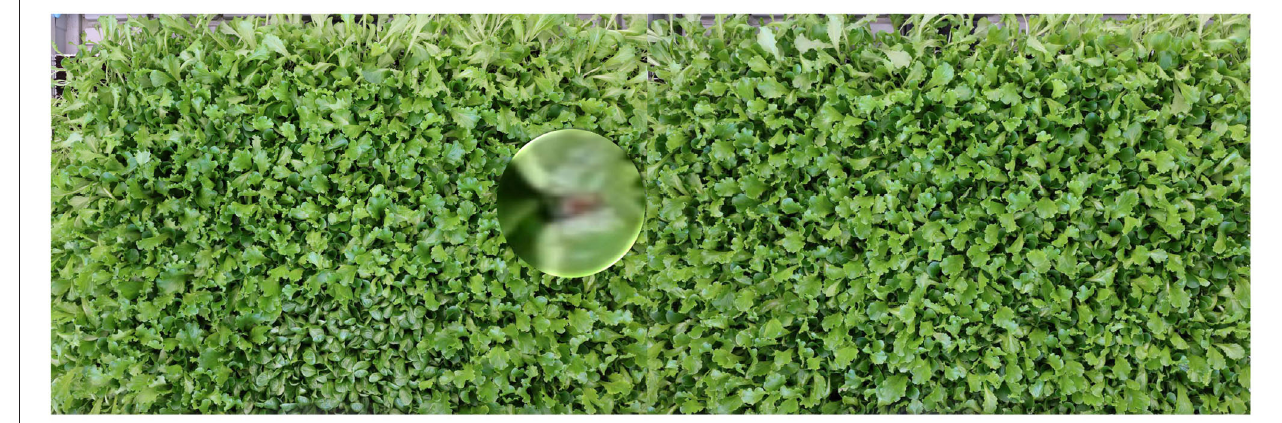
FIGURE 3 | The problem: given the image of a large canopy find all regions with tip-burn. Because tip-burn regions are very small and maybe each other close, segmentation is better than simple localization with bounding boxes. We propose a novel method for weakly supervised semantic segmentation, with only image class-labels annotations (classification accuracy 97.3%).